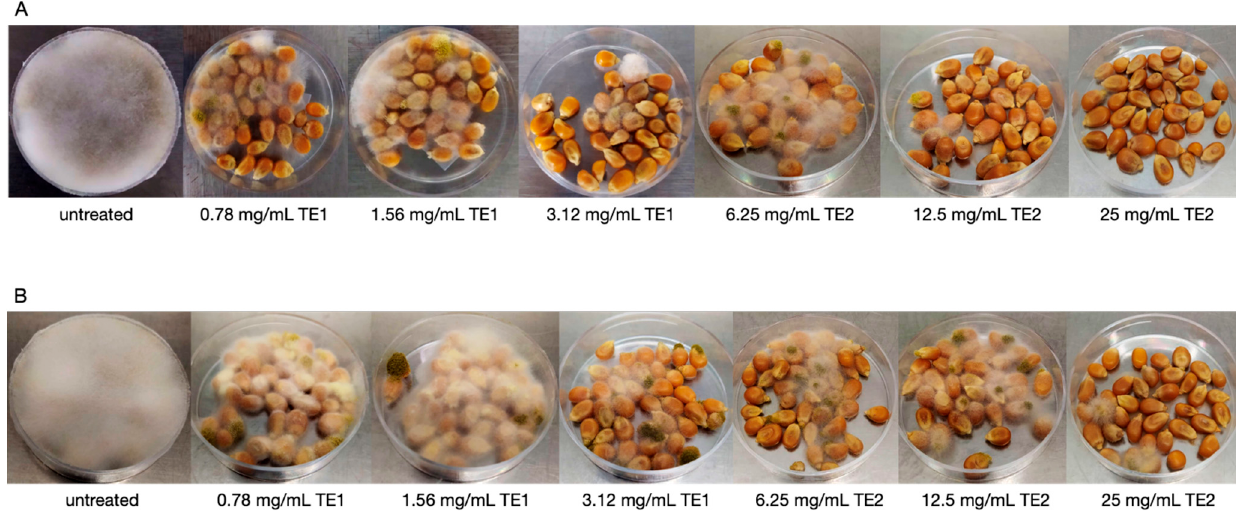
Figure 7. Growth of Aspergillus flavus on maize treated with TE1, TE2 and untreated, at ( A ) 10 days and ( B ) 20 days incu- bation.